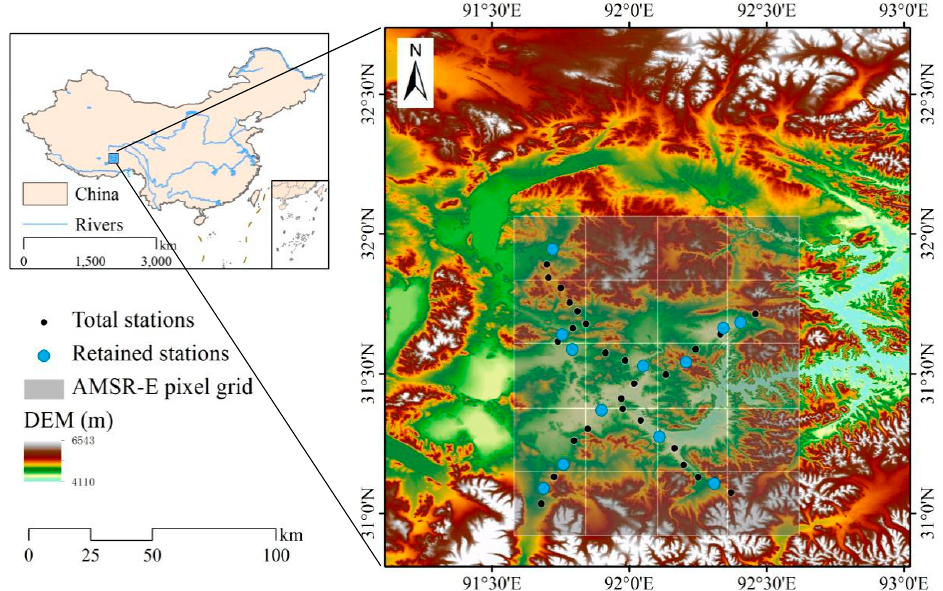
Figure 2. The geographic location of the study area with an overview of the Soil Moisture/Temperature Monitoring Network with 1.0° gridded blocks.